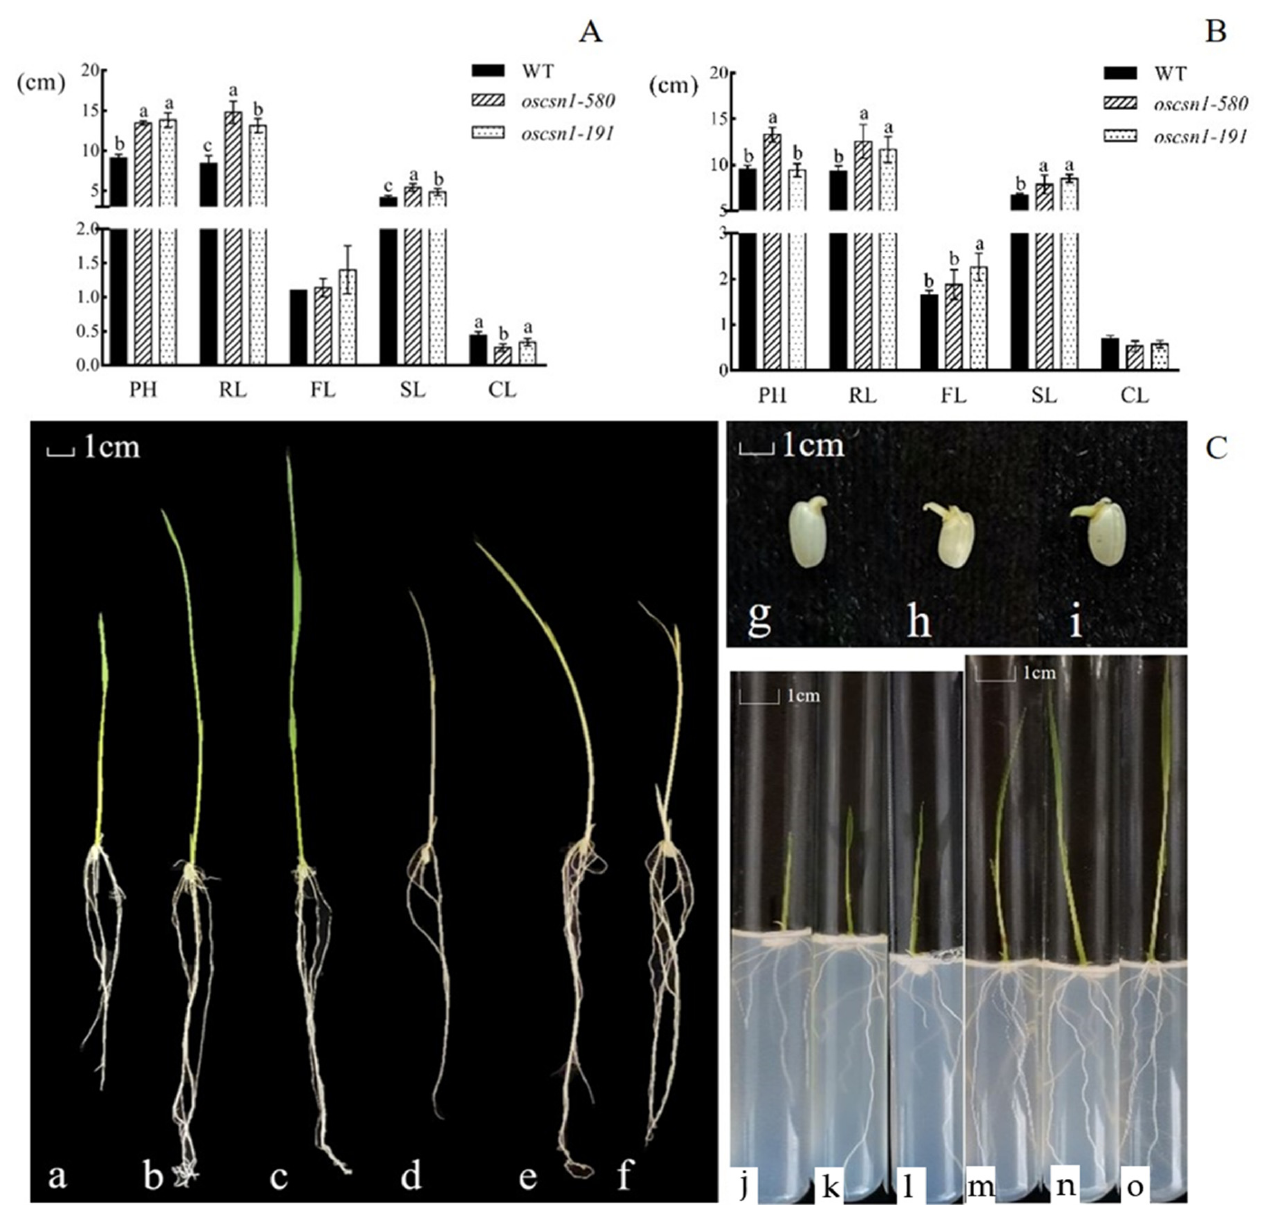
Figure 3. Phenotypic characteristics of wild type and oscsn1 mutants grown under different light conditions. The seeds were incubated in an artificial climate chamber set at 28 ◦ C for 10 days. ( A ) Plants were grown in the light. PH, plant height; CL, coleoptile length; RL, radicle length; FL, the first leaf length; SL, the second leaf length. The small letters a, b, c represent the within-group difference significance analysis. Data are mean ± SD (n = 5). Means with different letters are significantly different ( p < 0.05). ( B ) Plants were grown in the dark. PH, plant height; CL, coleoptile length; RL, radicle length; FL, the first leaf length; SL, the second leaf length. The small letters a, b represent the within-group difference significance analysis. Data are mean ± SD (n = 5). Means with different letters are significantly different ( p < 0.05). ( C ) Image of wild type and oscsn1 mutant seedlings grown under different light conditions. Scale bar = 1 cm. Wild type ( a ), oscsn1-580 mutant ( b ) and oscsn1-191 mutant ( c ) grown in the light for 10 days. Wild type ( d ), oscsn1-580 mutant ( e ) and oscsn1-191 mutant ( f ) grown in the dark for 10 days. Wild type ( g ), oscsn1-580 ( h ) and oscsn1-191 ( i ) seed germinated in light for 2 days. Wild type ( j ), oscsn1-580 ( k ) and oscsn1-191 ( l ) grown in light for 6 days. Wild type ( m ), oscsn1-580 ( n ) and oscsn1-191 ( o ) grown in light for 10